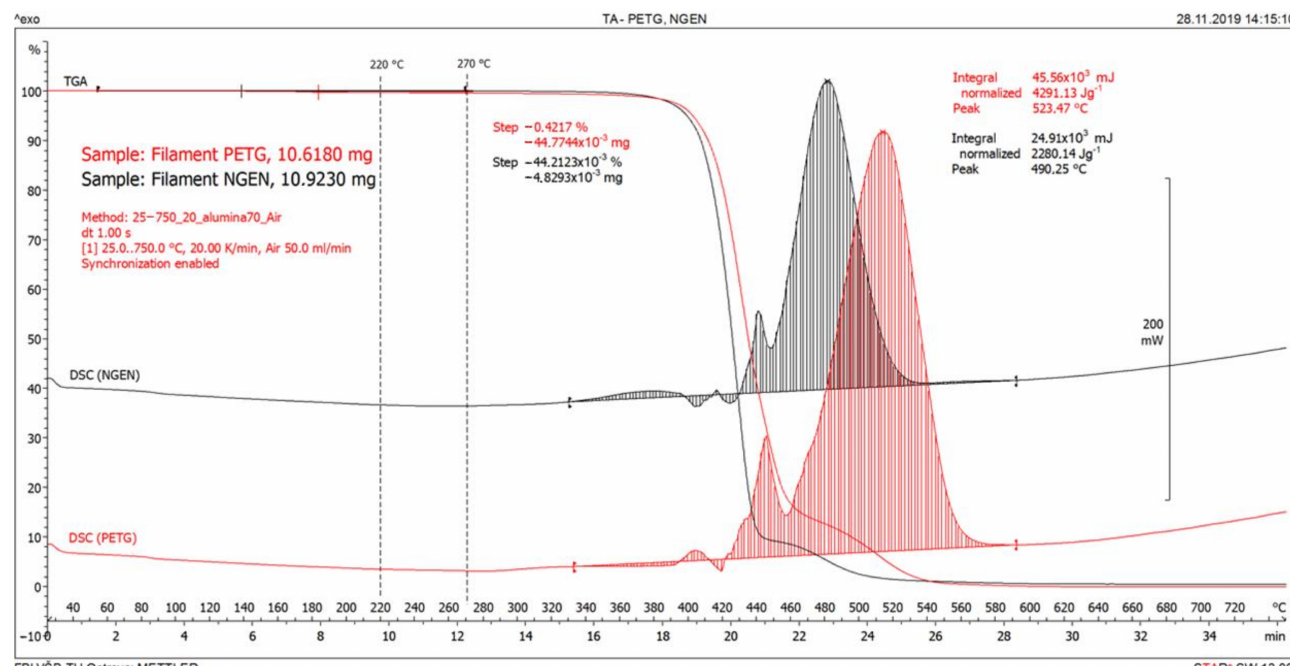
Figure 6. Thermal analyses with polyethylene terephthalate (PETG) and styrene free co-polyester (NGEN) filaments.